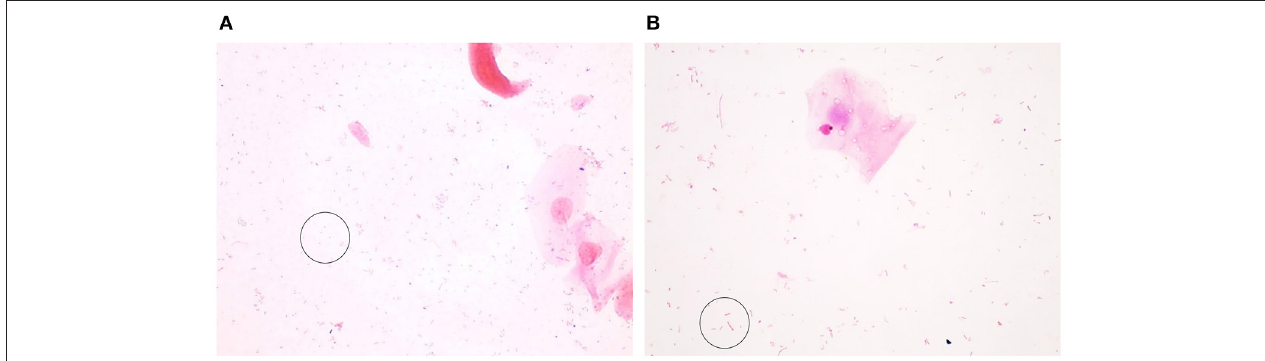
FIGURE 3 | Gram-negative bacteria seen in Gram-stained slides of sheep vaginal secretions. (A) Gram–negative cocci (within circle) were very difficult to visualize due to pale staining and potential for confusion with debris. There was not good concordance between the graders, and this was not included in the final scoring system. (B) Gram–negative rods (within circle) were associated with a normal, non-inflammatory state (micrographs are × 100 oil immersion).